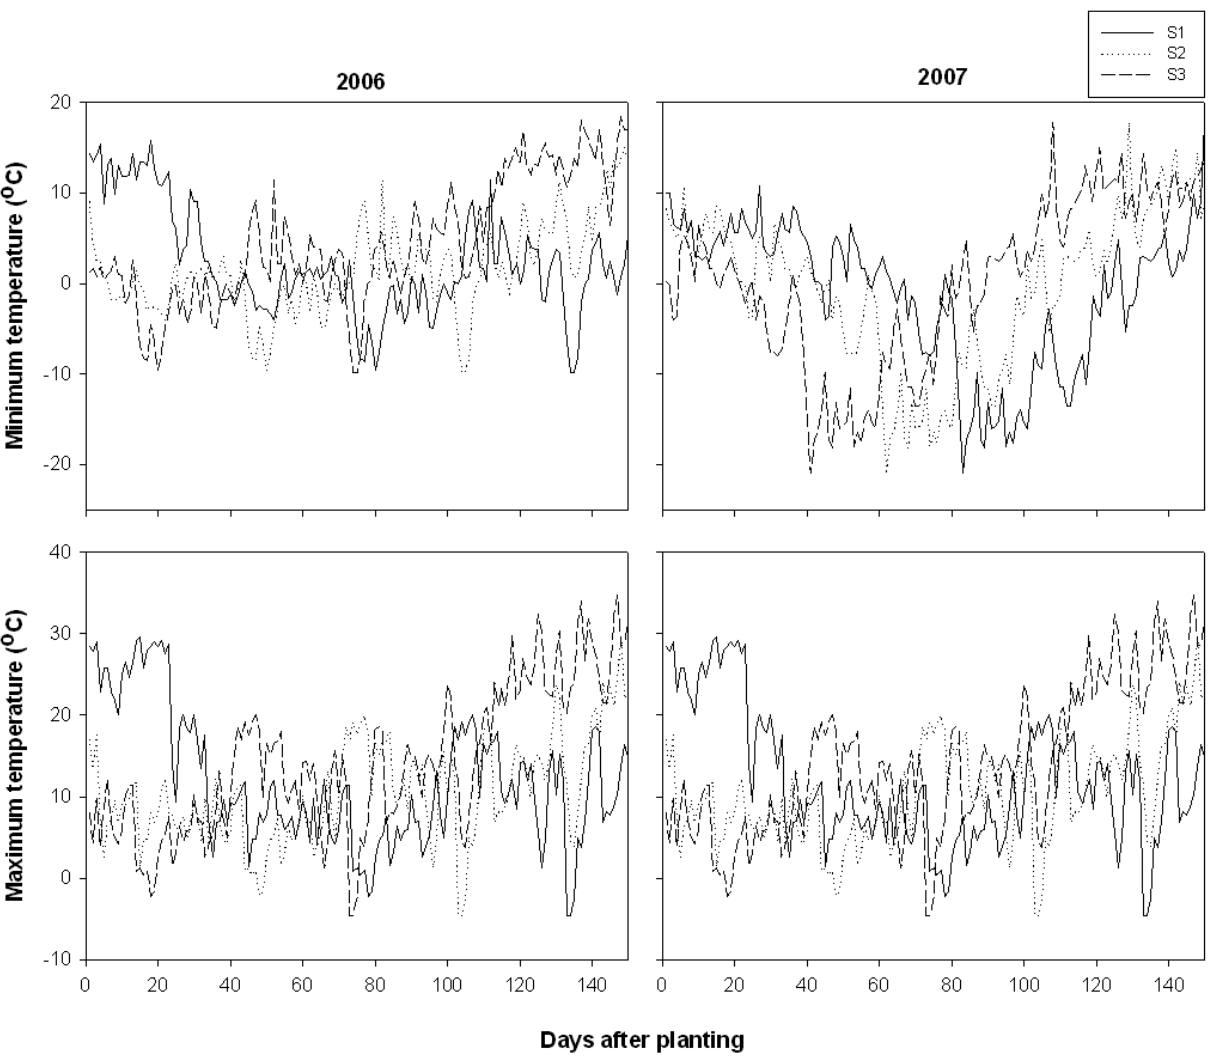
Fig. 1. Daily values of maximum and minimum air temperature (°C) in different sowing dates in 2006 and